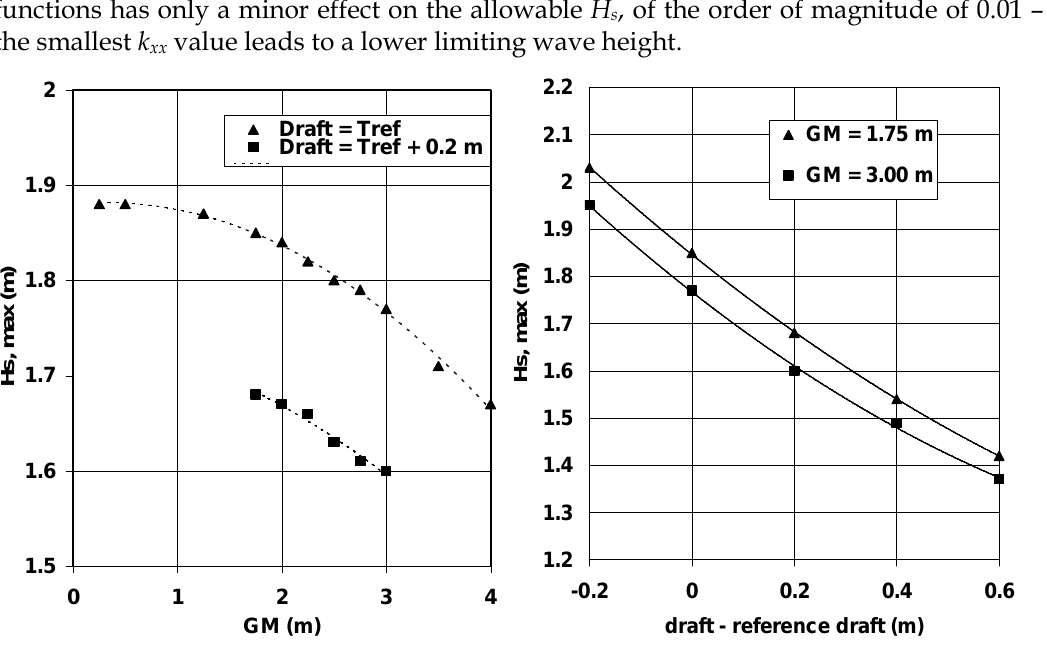
Figure 8.Estuary container vessel: maximum allowable significant wave height as a function of draft and metacentric height (GM).